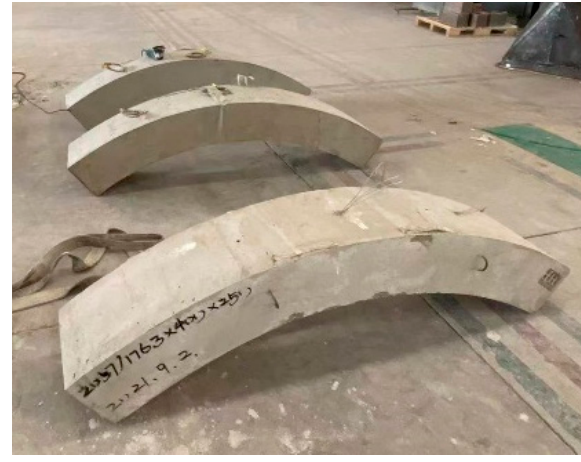
Figure 2. Concrete lining structure after demolding.